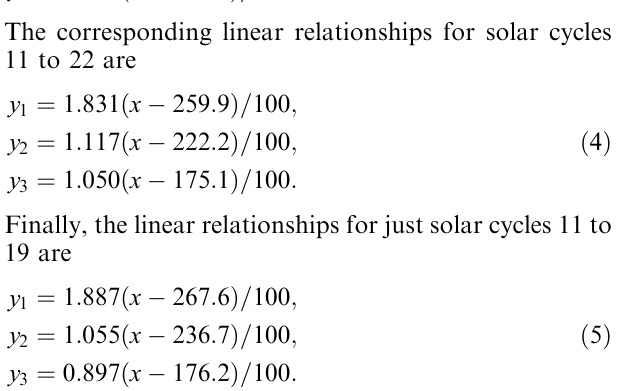
Table 3. Observed means and standard deviations of the aa index for the three largest geomagnetic storms of solar cycles 9 to 22, 11 to 22 and 11 to